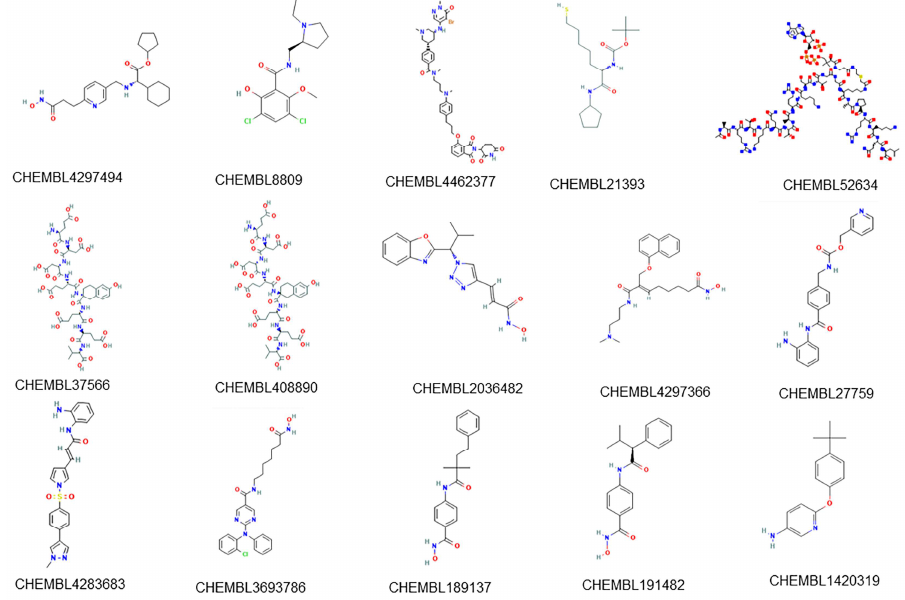
Figure 7. The 2D structures of 15 selected new compounds.